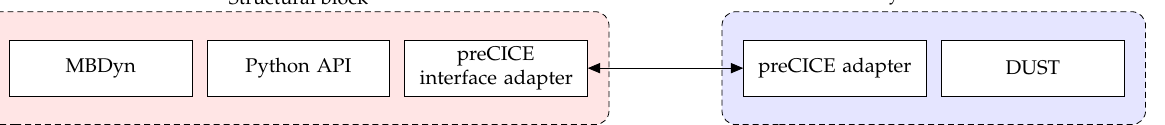
Figure 2. Scheme for motion interpolation (left) and force and moment transfer (right). Structural points are represented by red dots. Nodes of the aerodynamic mesh and panels centers are represented with plain dot and crosses, respectively;